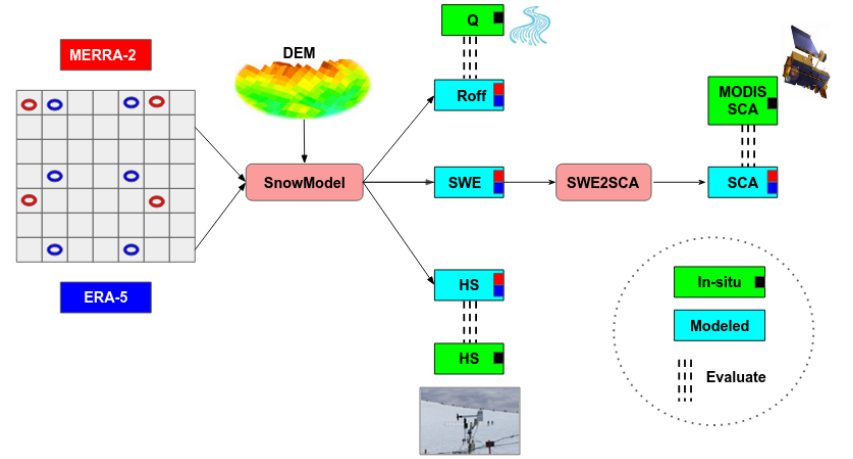
Figure 2. Flowchart of the method used to evaluate the performance of the model forced with ERA5 (in blue) and MERRA-2